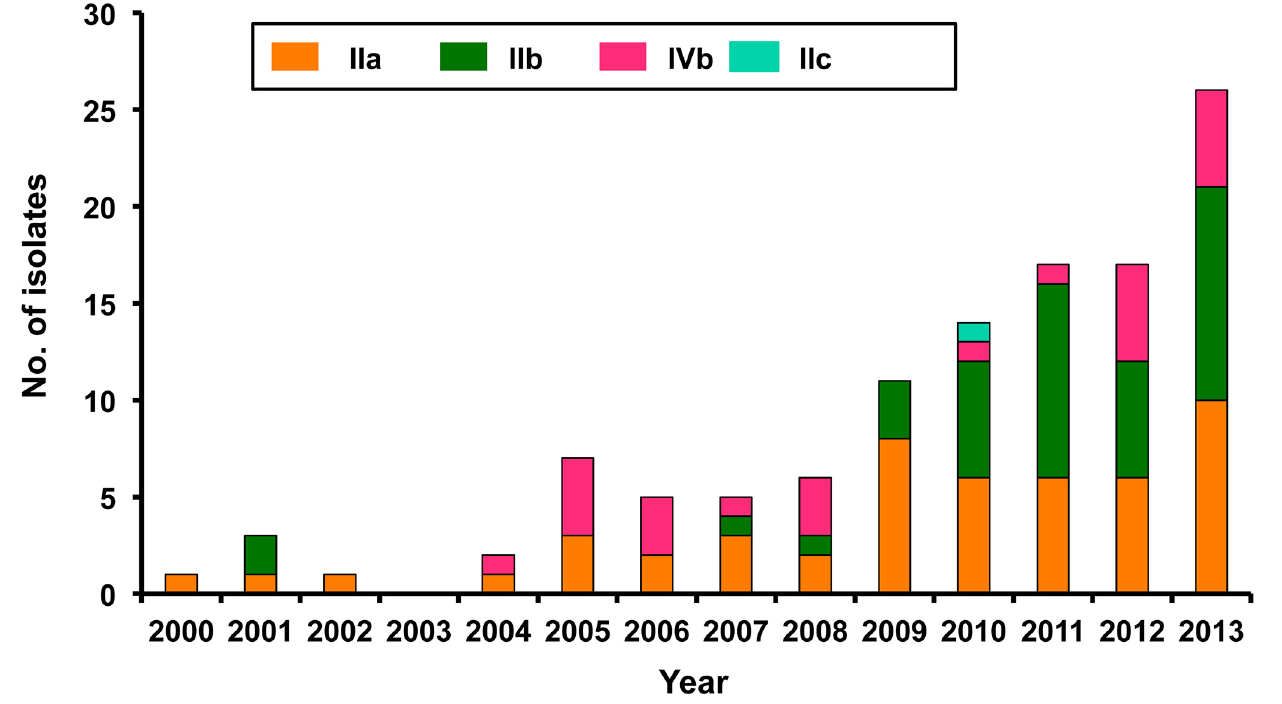
Fig 2. PCR serogroups of 132 isolates of L . monocytogenes . Annual proportion of four PCR serogroups of 132 isolates of L . monocytogenes isolated from three medical centers in Taiwan from 2000 to